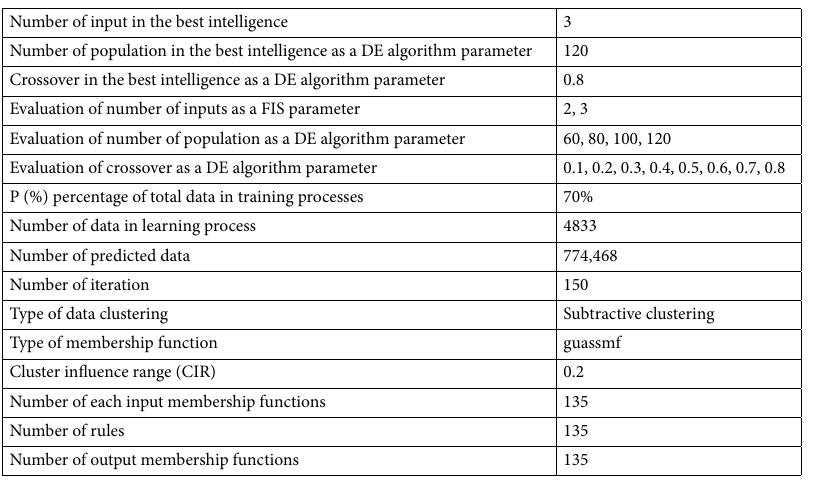
Table 2. Information of combining the FIS intelligence engine with DE